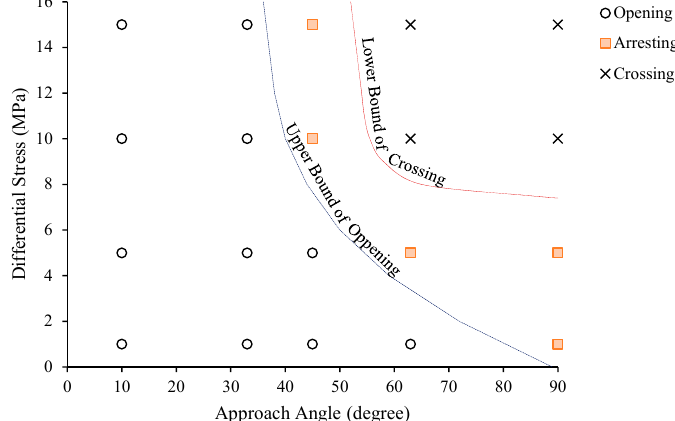
Figure 7. Correlation between approach angle and differential stress, based on discrete element method (DEM) simulations.